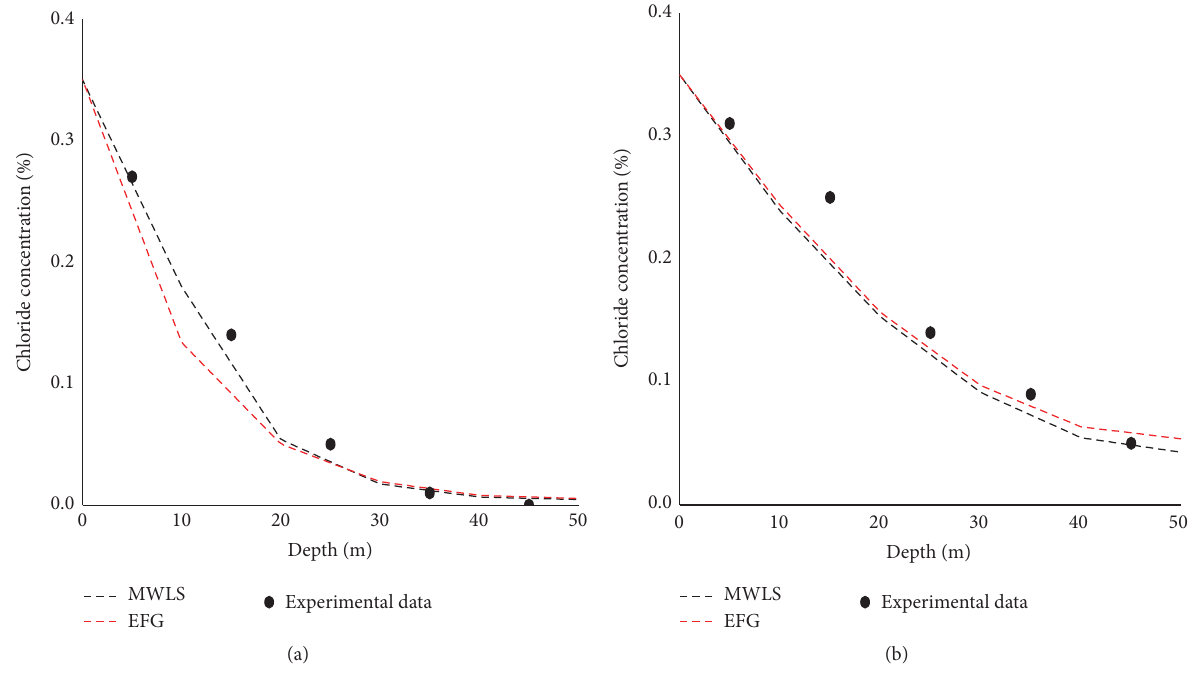
Figure 7: Comparison of chloride concentration computed by MWLS and EFG and experimentally measured data after exposure time: (a) 𝑡 = 0.5 years and (b) 𝑡 = 2 years.